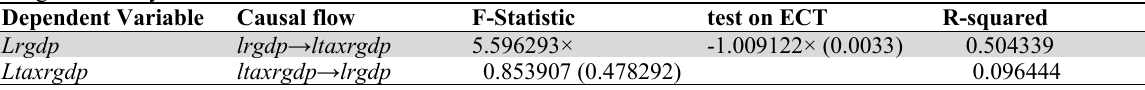
Granger Causality results Dependent Variable